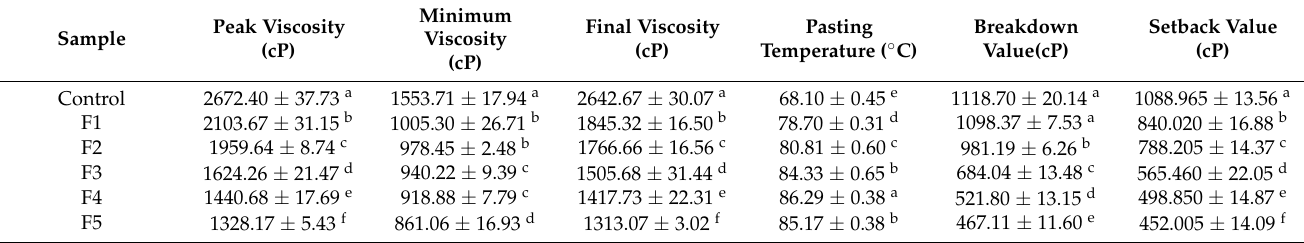
Table 3. Pasting properties of whole-wheat